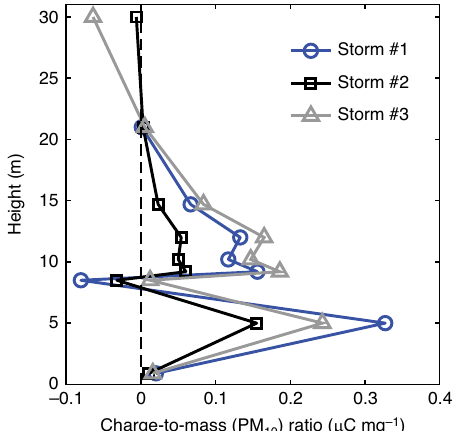
Fig. 8 Vertical pro fi les of the charge-to-mass (PM 10 ) ratios for storms #1-#3. For storm #1, the ambient temperature ( T ) and relative humidity (RH) are in the range of 16.7 ± 1.2 ∘ C and 17.4 ± 3.3%, respectively. For storm #2, the ambient T and RH are in the range of 20.2 ± 0.5 ∘ C and 20.1 ± 0.9%, respectively. For storm #3, the ambient T and RH are in the range of 9.0 ± 1.4 ∘ C and 15.6 ± 2.5%,